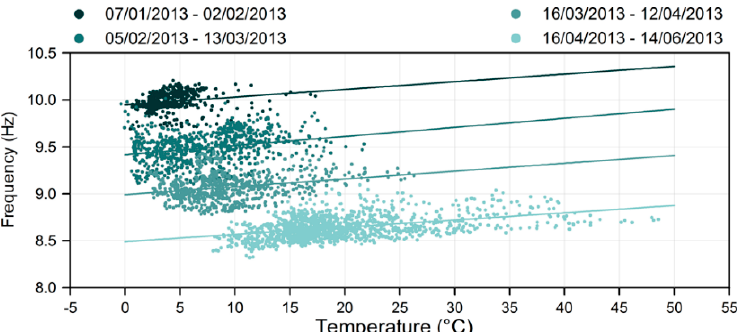
Figure 9. Gabbia Tower in Mantua Variation of identified natural frequencies (Figure 6) [19]. Figure 10. Gabbia Tower in Mantua. Natural frequency of the local mode L1 of Figure 1 plotted with respect to the outdoor temperature. The natural frequency exhibits clearly decrease in time, detecting possible damage; the clouds of temperature-frequency points, corresponding to each of the 4 reference periods, are characterized by similar slope of the best fit line [19].